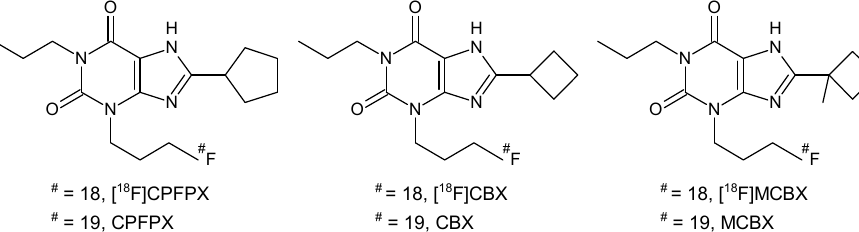
Figure 1. Structures of 8-cyclopentyl-3-(3-[ 18 F]fluoropropyl)-1-propylxanthine ([ 18 F]CPFPX), 8-cyclobutyl-3-(3-[ 18 F]fluoropropyl)-1-propylxanthine ([ 18 F]CBX), 3-(3-[ 18 F]fluoropropyl)-8-(1-methylcyclobutyl)-1-propylxanthine ([ 18 F]MCBX) and their nonradioactive counterparts.